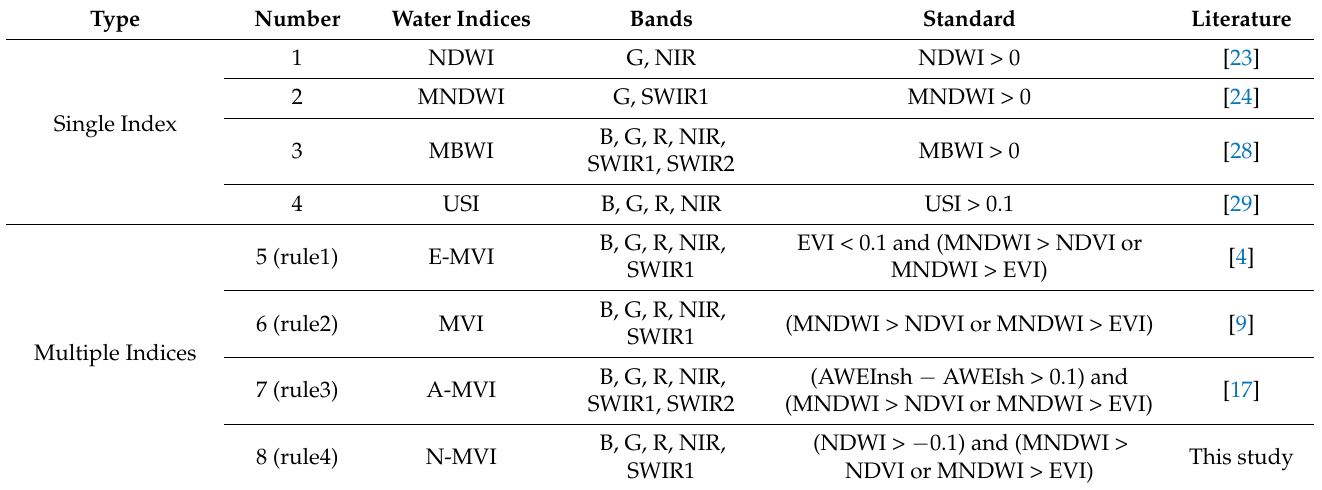
Table 1. Water mapping